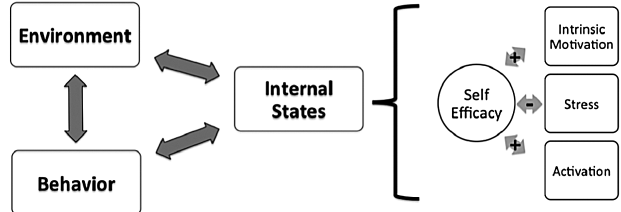
FIG. 1. The three major classes of determinants according to Social Cognitive Theory are shown on the left. The arrows represent the reciprocal causal relationships that exist between each of the classes. On the right, the internal state class is broken down into the four affective states that were measured in this study. The relationships between the self-efficacy state and each of the complementary states are shown in the